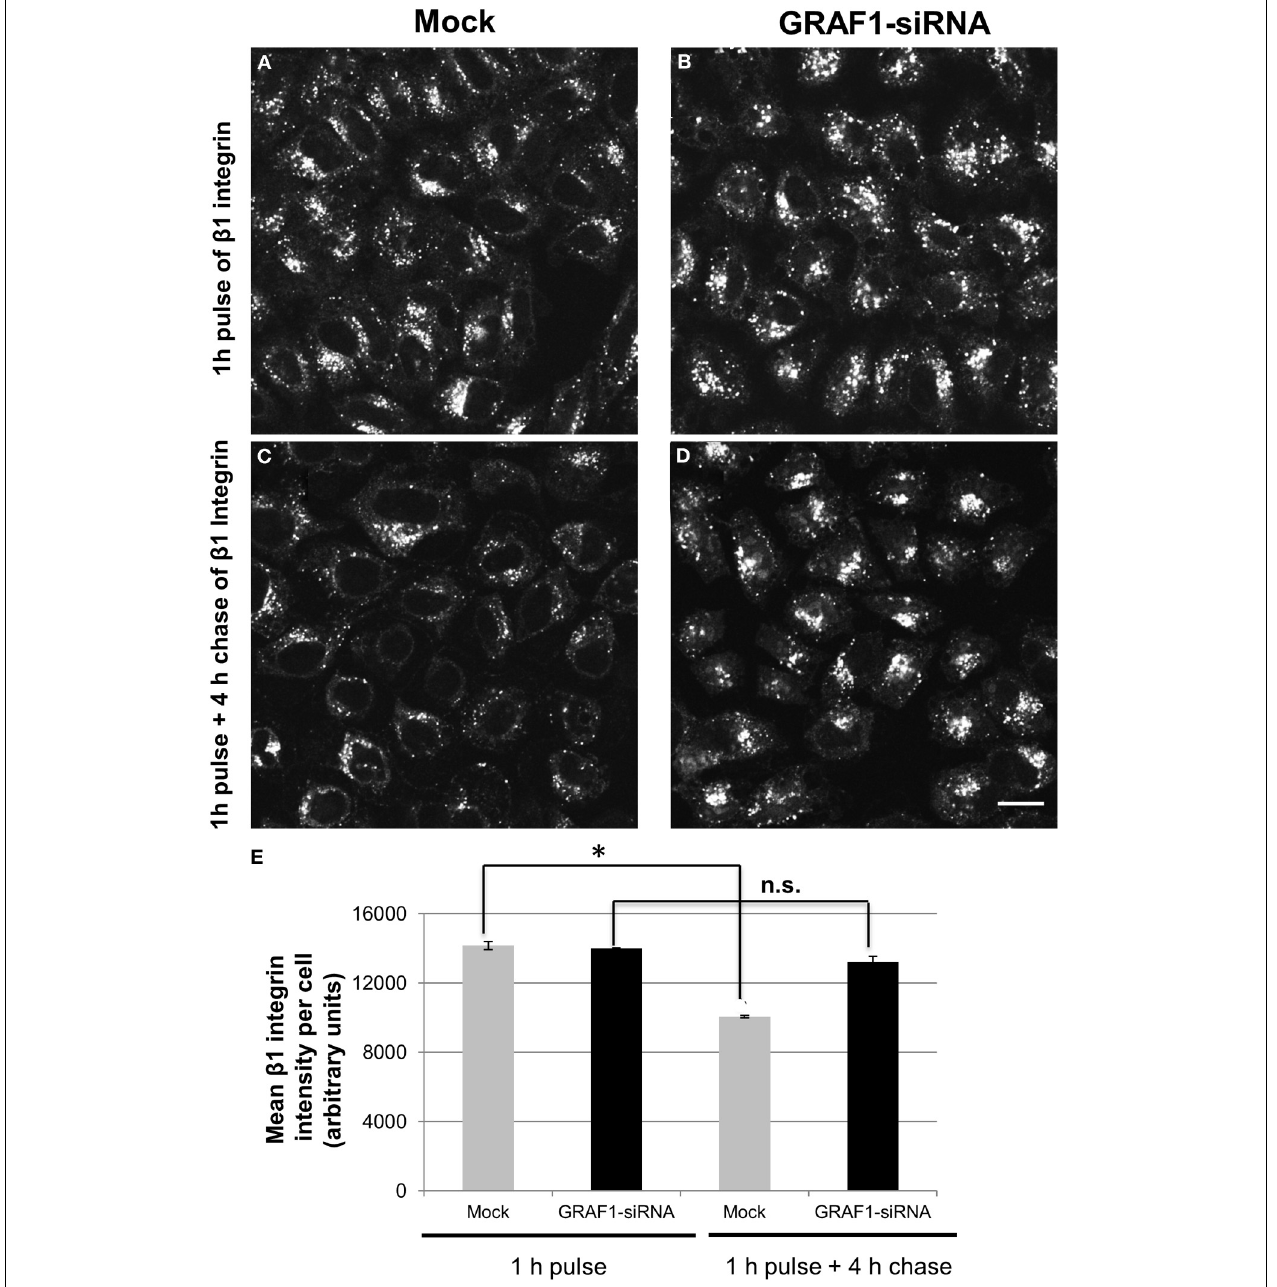
FIGURE 5 | The recycling of β 1 integrin is delayed upon GRAF1-depletion. (A) Cells grown on coverslips were either mock-treated or (B) treated with GRAF1-siRNA for 72h. Cells were incubated with mouse anti- β 1 integrin for 1h at 37 ◦ C, followed by a short acid strip and either fixed directly (A,B) or “chased” in complete media for 4h, followed by a second